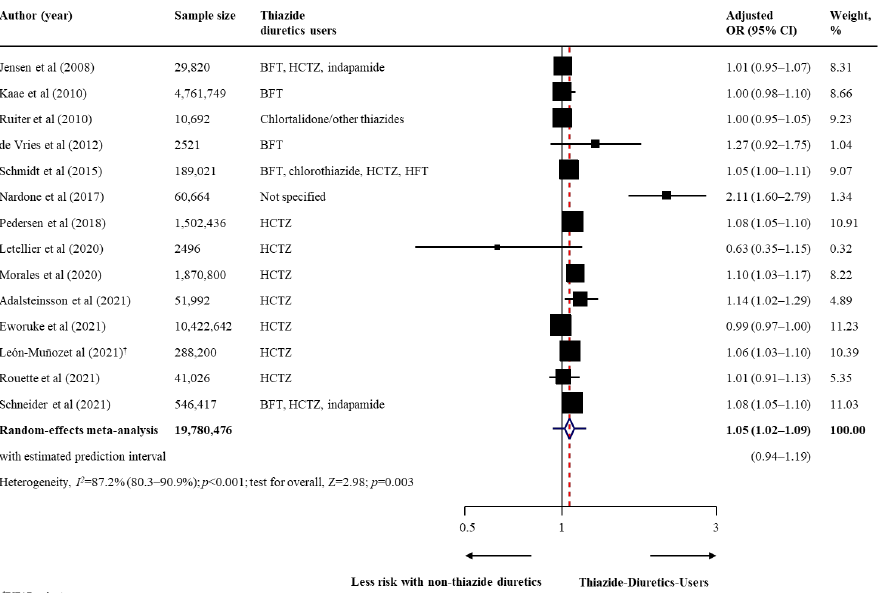
Figure 2. Effect of the use of thiazide diuretics and the risk of basal cell carcinoma. Abbreviations: BFT, bendroflumethiazide; CI, confidence interval; HCTZ, hydrochlorothiazide; HFT, hydroflumethiazide; OR, odds ratio